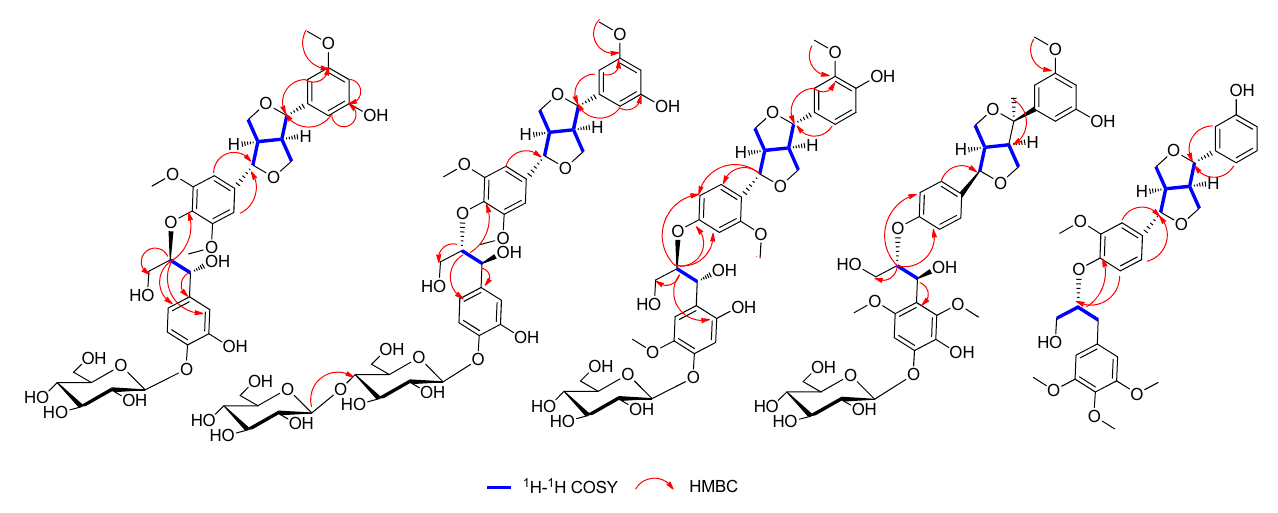
Figure 2. The CD spectra of compounds 1 – 5 (MeOH). Compound 2 was obtained as a white amorphous powder, and its molecular for- mula was confirmed asC 42 H 54 O 21 , determined by HRESIMS 895.8730 [M + H] + (calcd. for C 42 H 55 O 21 895.8730). Careful comparison of the NMR data of 2 (Tables 1 and 2) with those of 1 revealed that the 2 was a glycoside of 1 located at C-4 ′′′ , which was confirmed by HMBC (Figure 3) correlations between anomeric proton H-1 ′′′′ ( δ H 4.25, d, J = 7.7)and C-4 ′′′ ( δ C 70.4). The two sugars were confirmed as β -D-configuration by the anomeric protons coupling constant ( δ H 4.24, d, J = 7.7, H-1 ′′′ and δ H 4.25, d, J = 7.7, H-1 ′′′′ ), further enzymatic Table 1. 1 H NMR (500 MHz) data of 1 – 5 in DMSO- d hydrolysis, and GC-MS analysis. The similar coupling constants ( J H-7, H-8 , J H-7 ′ , H-8 ′ , and J H-7 ′ ’, H-8 ′ ’ )of 2 showed the relative configuration was consistent with 1. However,the CD spec- trum of 2 (Figure 2) showed a positive Cotton effect at 228 nm and 285nm, illustrating that the absolute configuration of 2 was 7 S , 7 ′ S ,7 ′′ S , 8 R , 8 ′ R , 8 ′′ S. Therefore, the structure of